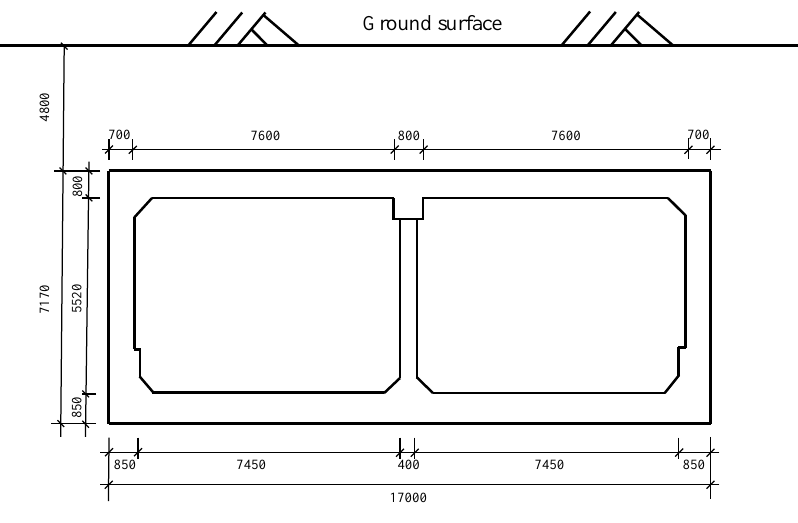
Figure 8. Cross-section of Daikai station (unit: mm).